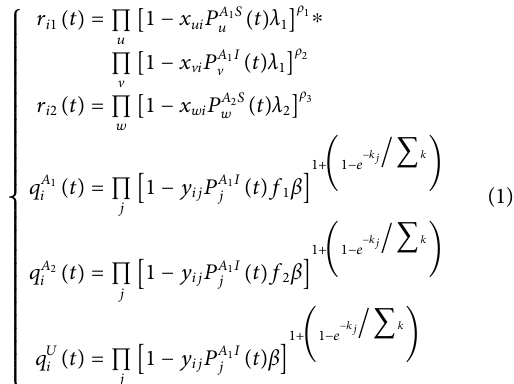
Here, u represents the number of neighbors of individual i in state A 1 S , v represents the number of neighbors in state A 1 I , and w represents the number of neighbors in state A 2 S . Based on the states ( US , A 1 S , A 2 S , A 1 I ) are presented in Figure 5. As shown in Figure 5, each individual will transmit its states according to the transition trees and its current state in each time step. Individuals who are aware of the positive (negative) information tend to forget the information with probability δ 1 ( δ 2 ). μ denotes the probability of being recovered for an infected individual. individual i by using MMCA are listed in Eq (2):